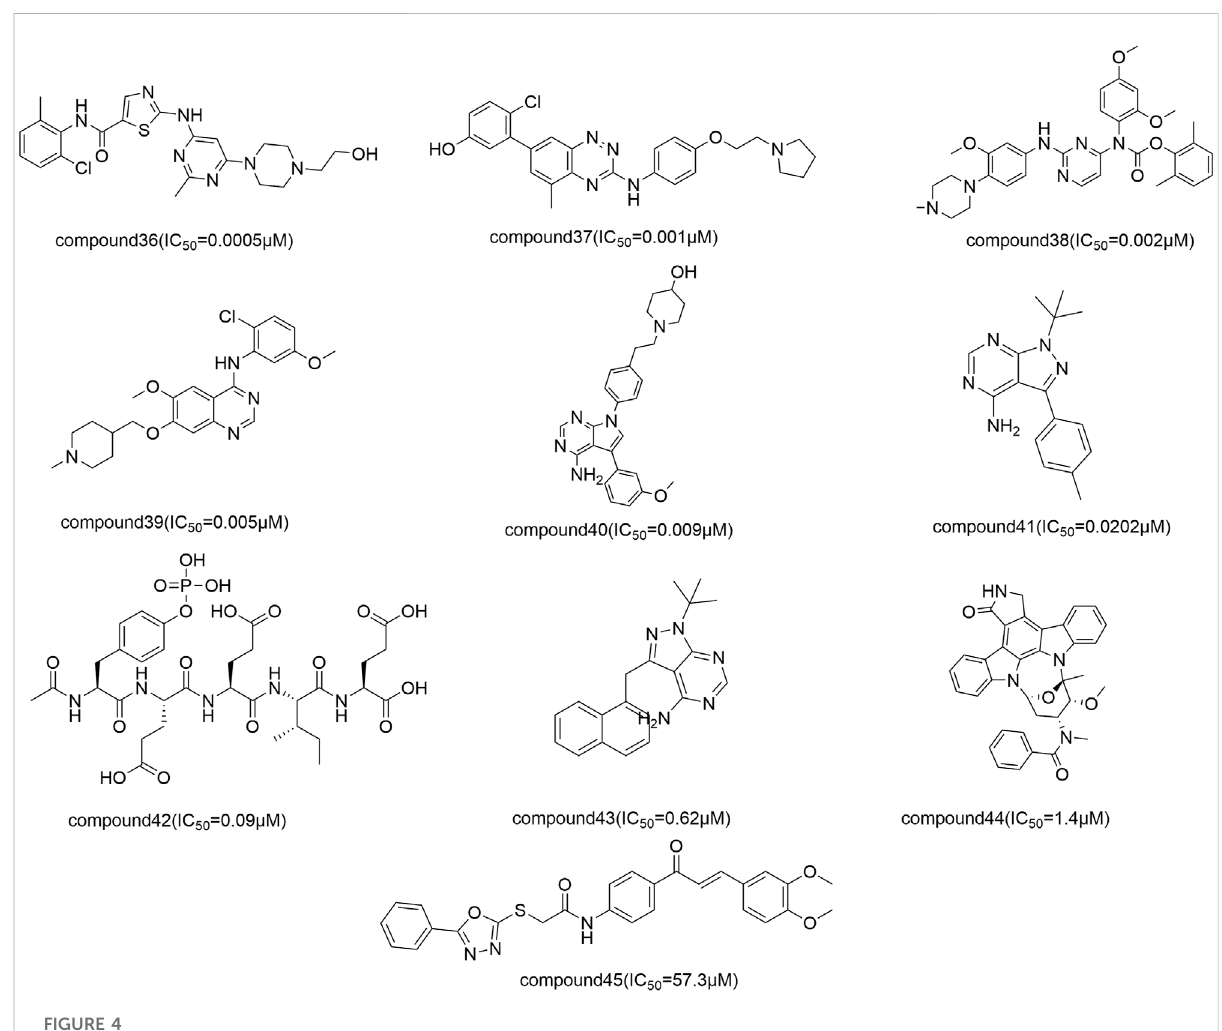
FIGURE 4 Structural of top 10 highly active compounds in EF.